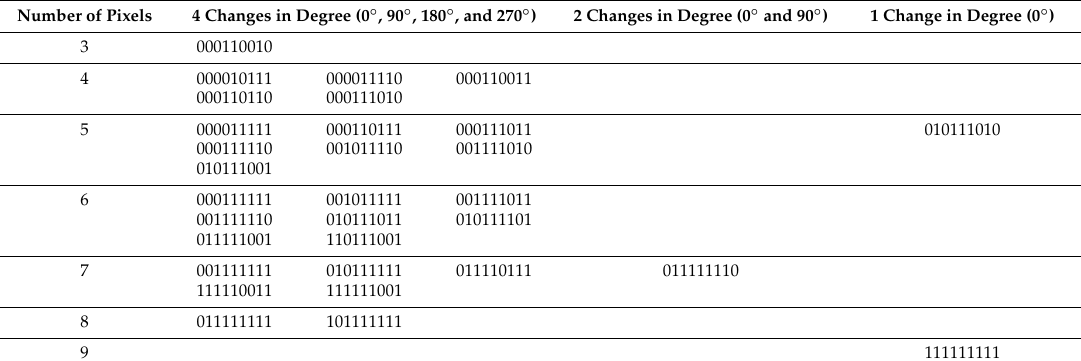
Table 1. Thinning texture template binarization coding.